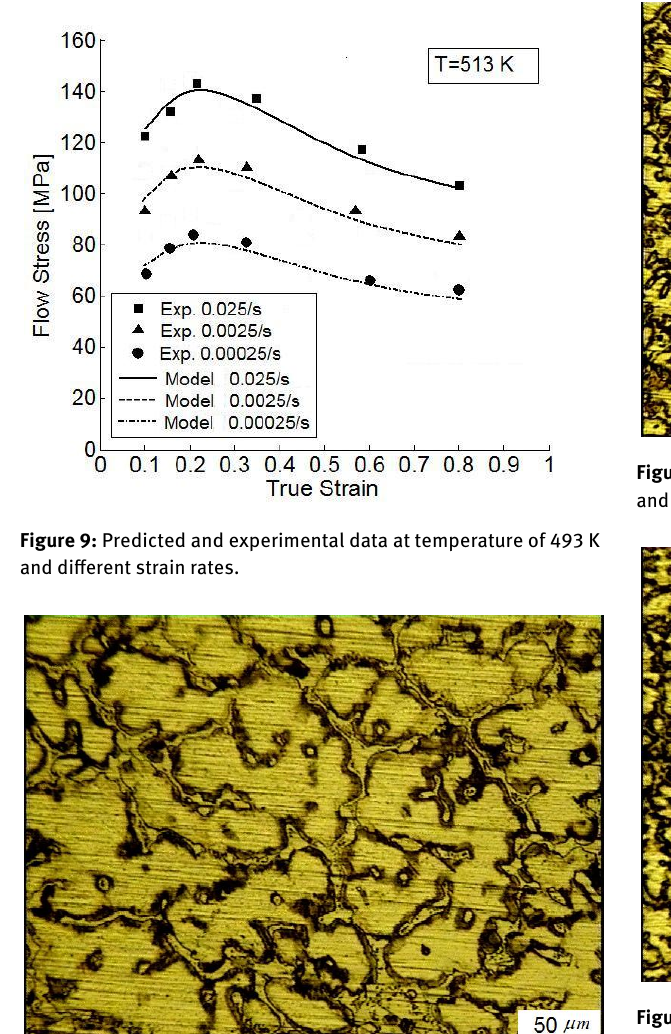
Figure 12: Optical microscope image of as-cast AZ30 magnesium alloy at strain of 0.3 and temperature of 493 K and strain rate of 0.025 s –1